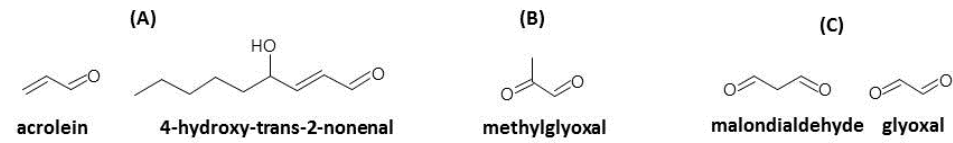
Figure 1. Structures of reactive carbonyl species: α , β -unsaturated aldehydes ( A ); keto-aldehyde ( B ) and di-aldehydes ( C ).